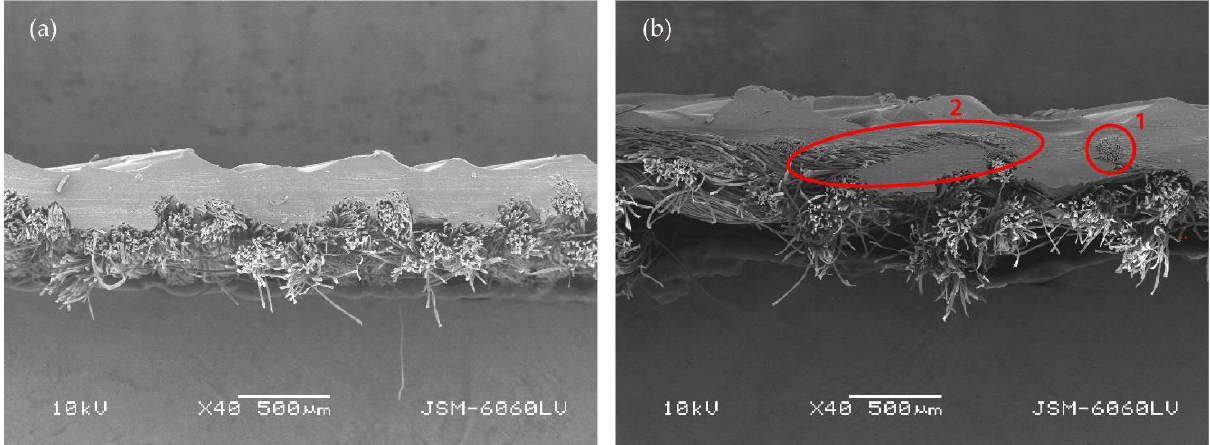
Figure 9. Cross-section (cut in the weft direction) of 3D printed fabrics at z = 0.25 mm (mag. 40×): ( a ) simple fabric T13Z 15; ( b ) double fabric DT13Z 30.